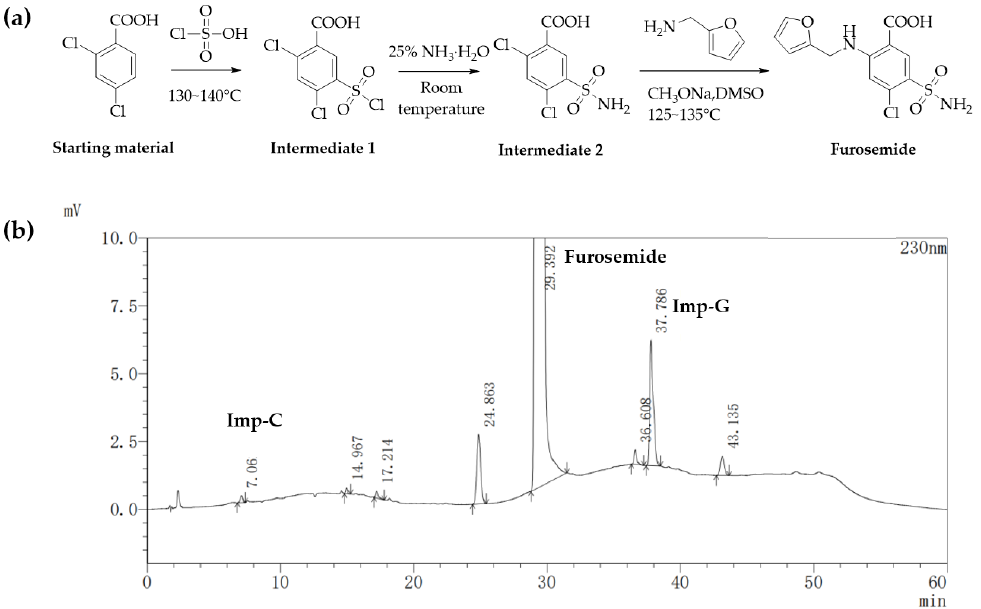
Figure 1. ( a ) Synthetic route of furosemide; ( b ) Representative HPLC chromatogram of furosemide with impurity G.